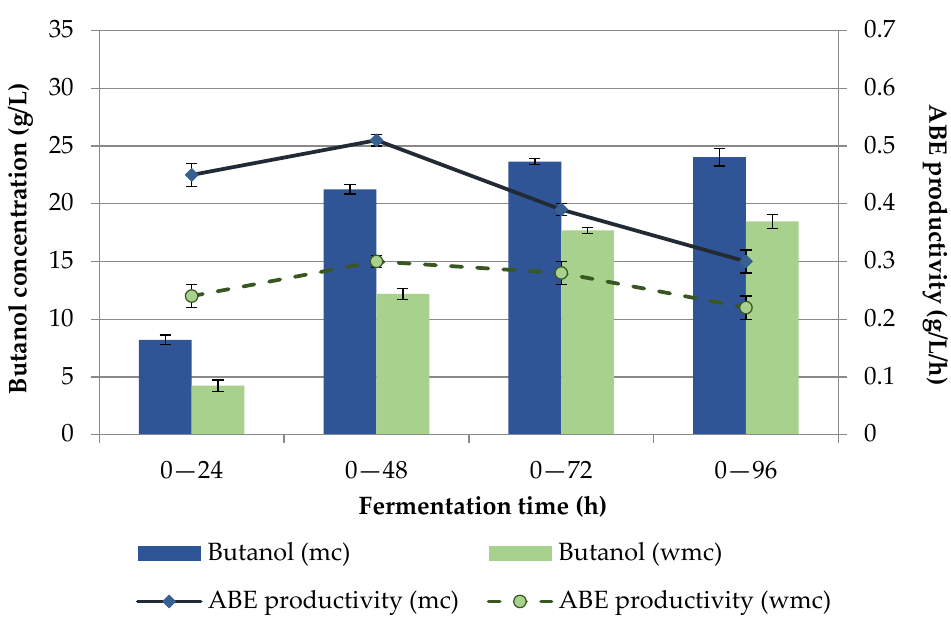
Figure 1. Butanol production and ABE productivity with simultaneous hydrolysis and fermentation (SSF) processes (SSF mc — with mineral compounds; SSF wmc — without mineral compounds).